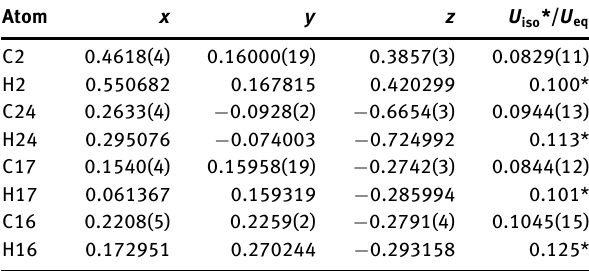
Table 2: Fractional atomic coordinates and isotropic or equivalent isotropic displacement parameters (Å 2